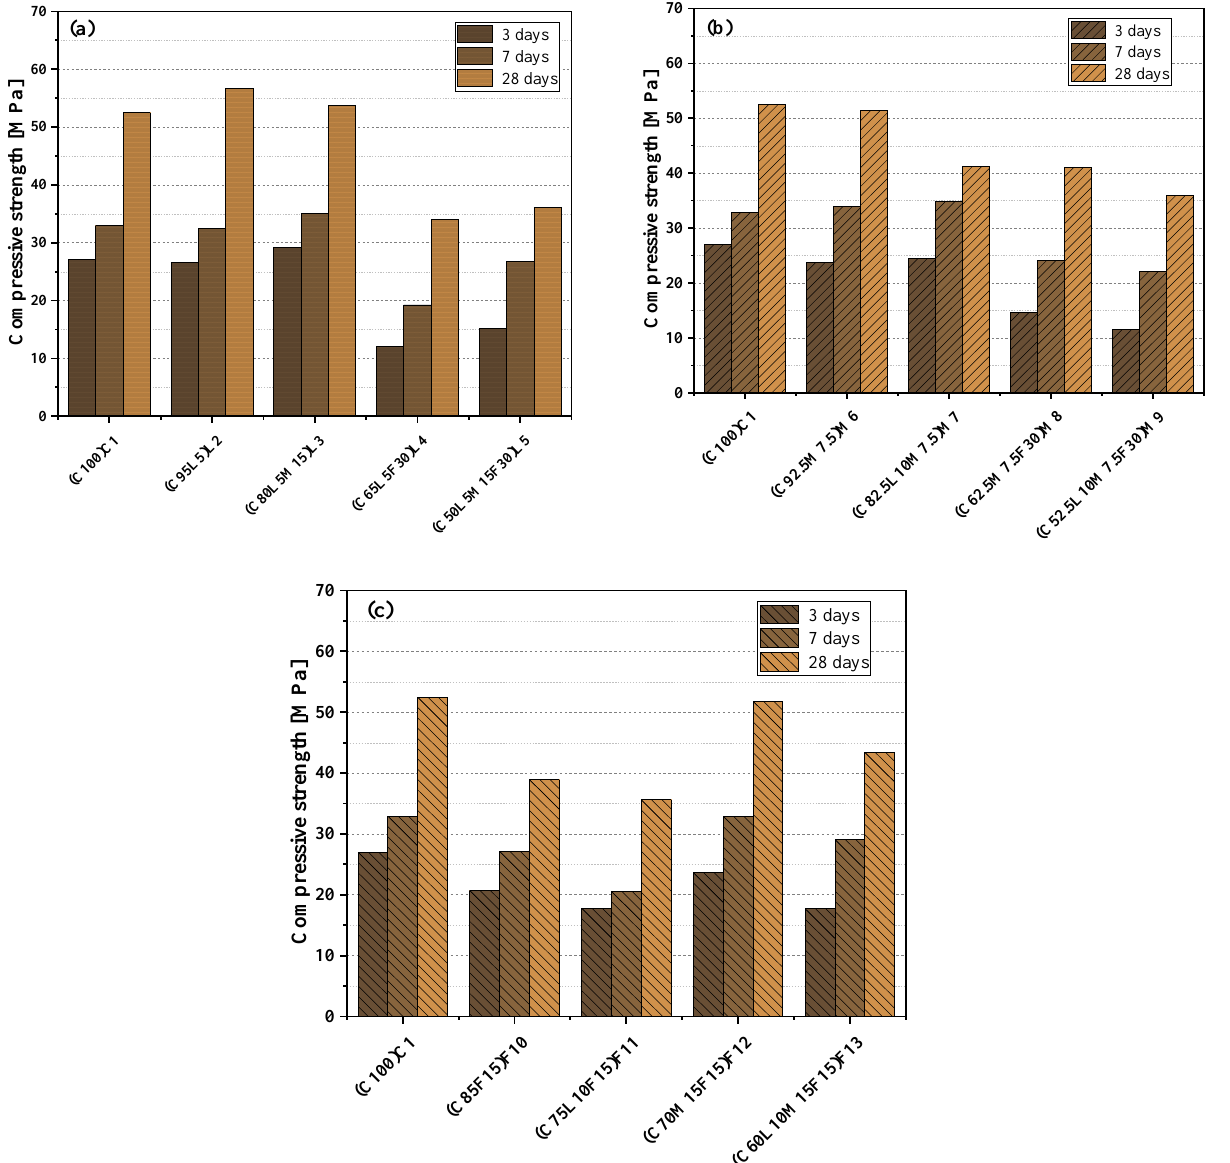
Figure 6. Compressive strength: ( a ) the control specimen and LS system; ( b ) the control specimen and MK system; ( c ) the control specimen and FA